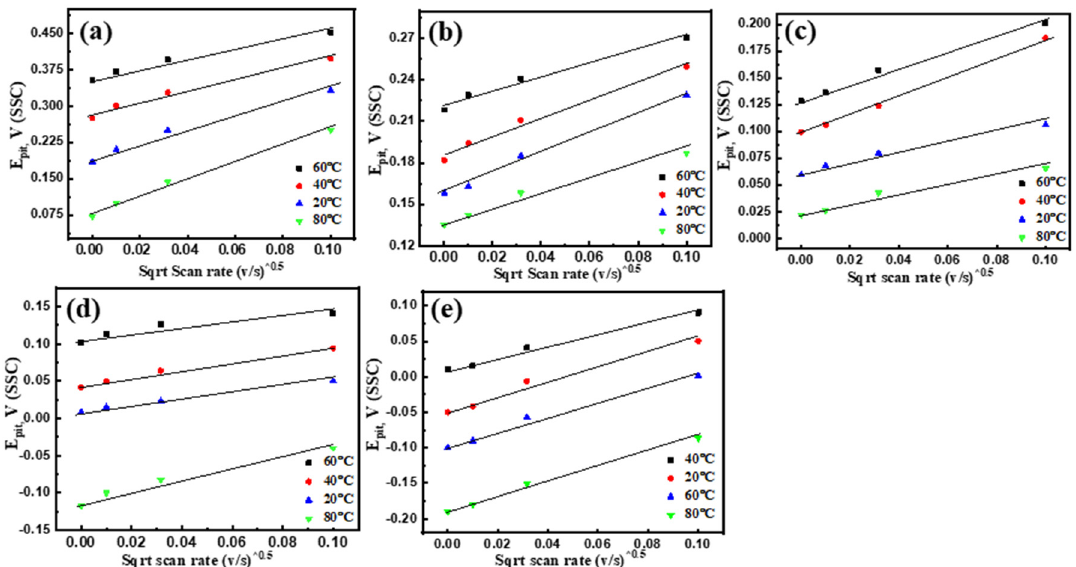
Figure 5. Effect of the temperature and the polarization scan rate on the apparent pitting potential of the MMSS steel at different temperatures, using variable concentrations of ( a ) 0.1, ( b ) 1 ( c ) 10, ( d ) 35.5, and ( e ) 100 g·L − 1 of NaCl in a saturated CO 2 environment (pH~5).